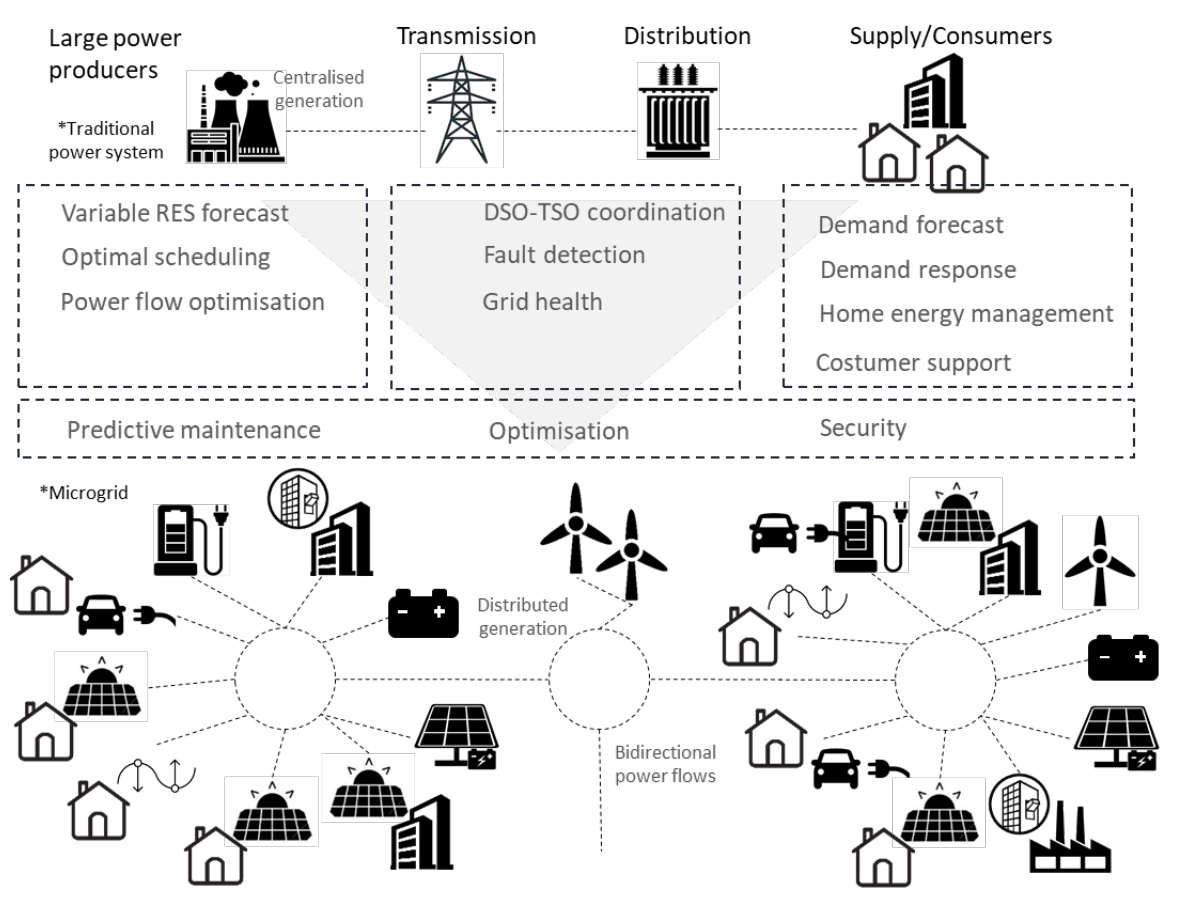
Figure 4. The AI-aided new energy